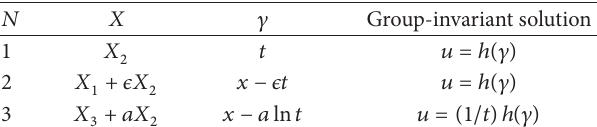
Here 𝜖 = 0 , ± 1, and 𝑎 is an arbitrary